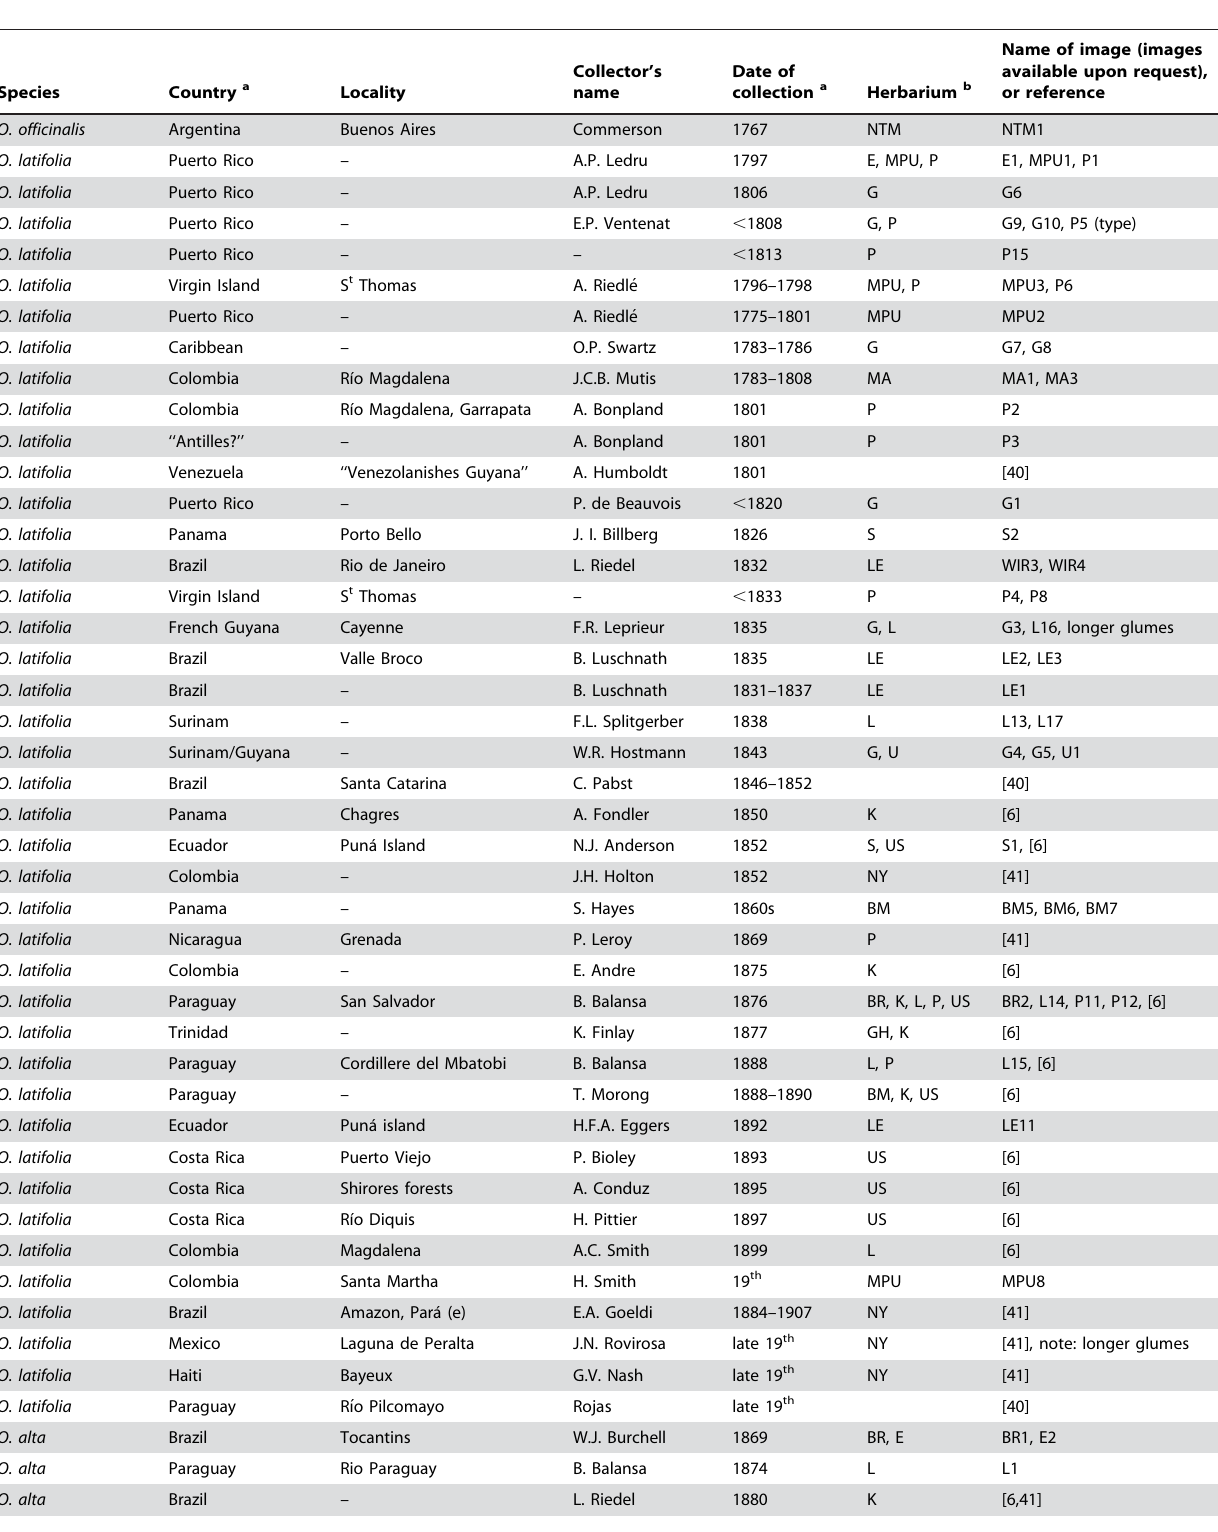
Table 1. Specimens of the ‘ O. officinalis complex’, collected in the Americas in the 18 th and 19 th centuries, as observed from herbariums or as referenced from